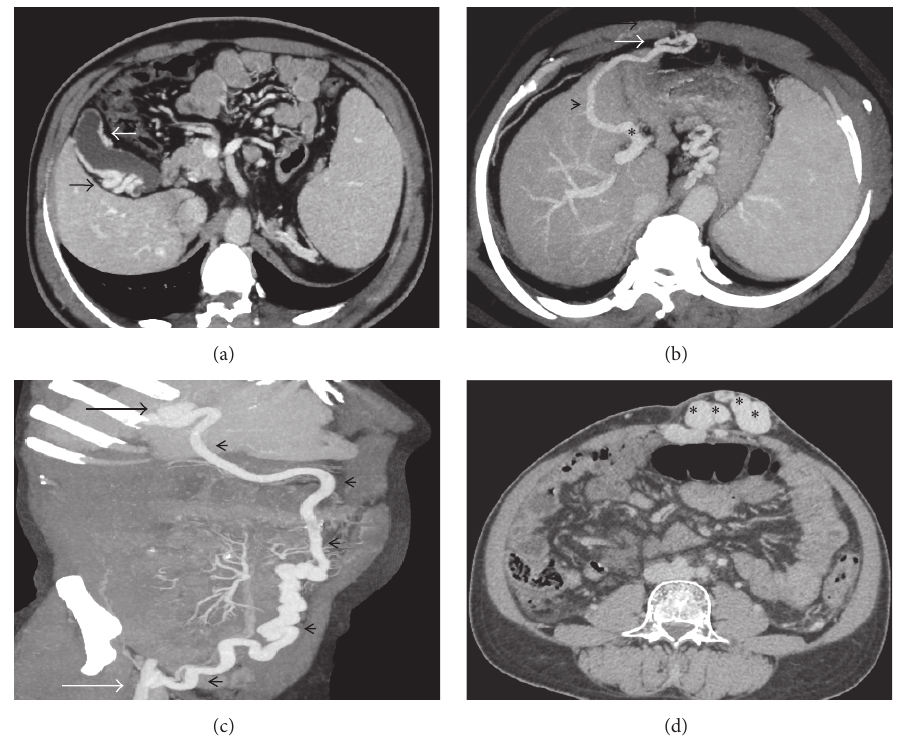
Figure 7: (a) Axial CECT image showing multiple pericholecystic collaterals (arrows); (b) axial-oblique MIP image showing a right infradiaphragmatic type of shunt (arrowhead) arising from the left portal vein branch (asterisk) and draining into the intercostal vein; (c) coronal-oblique MIP image demonstrating a prominent recanalized paraumbilical vein (arrowheads) arising from the left branch of portal vein (black arrow) and draining into the right internal iliac vein (white arrow); (d) caput medusa, multiple periumbilical abdominal wall varices